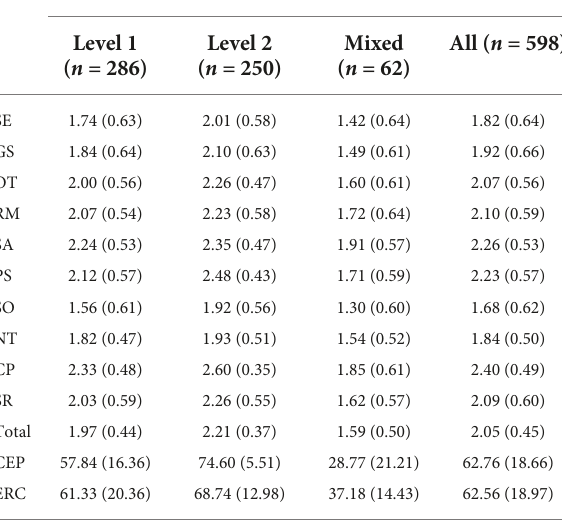
TABLE 3 Means and standard deviations for SRL strategy use, comprehensive English proficiency, and English reading